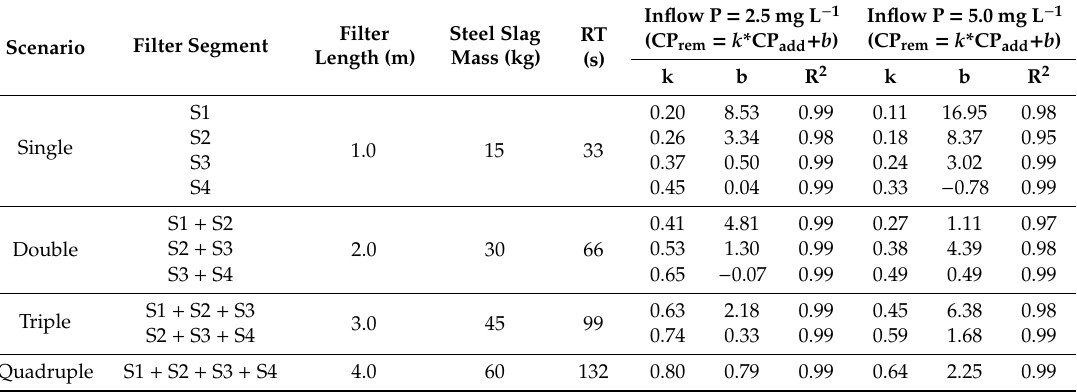
Table 1. Summary of steel slag mass, retention time (RT), and filter length condition, and the relationship between CP rem and CP add for each scenario. CP rem : cumulative removed P, mgkg − 1 ; CP add : cumulative added P, mg kg − 1 ; k : slope; b :